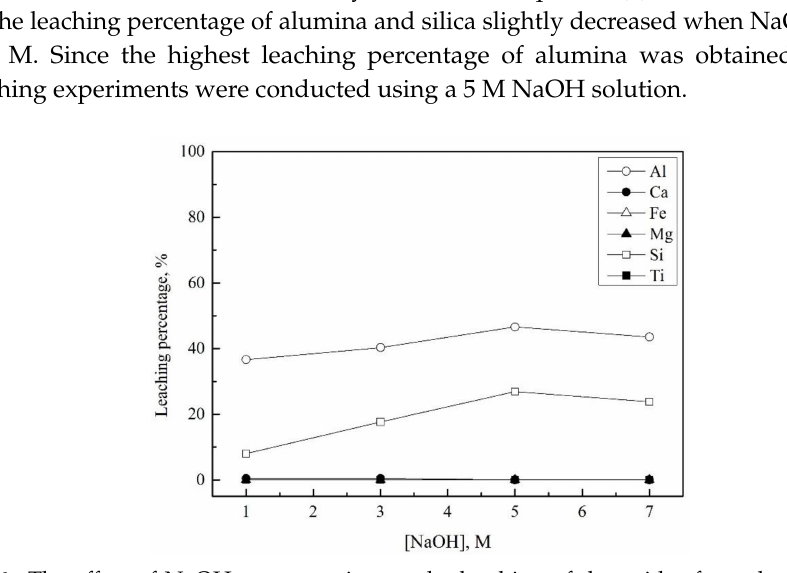
Figure 6. The effect of NaOH concentration on the leaching of the oxides from the